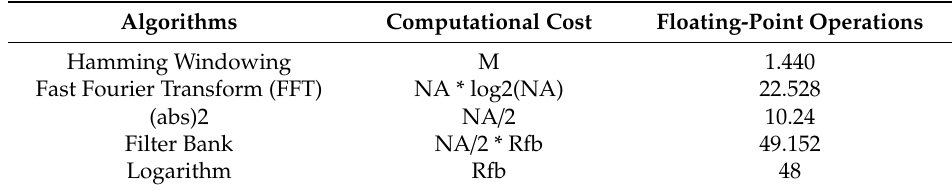
Table 1. The computational cost of the vibration event detection approaches.